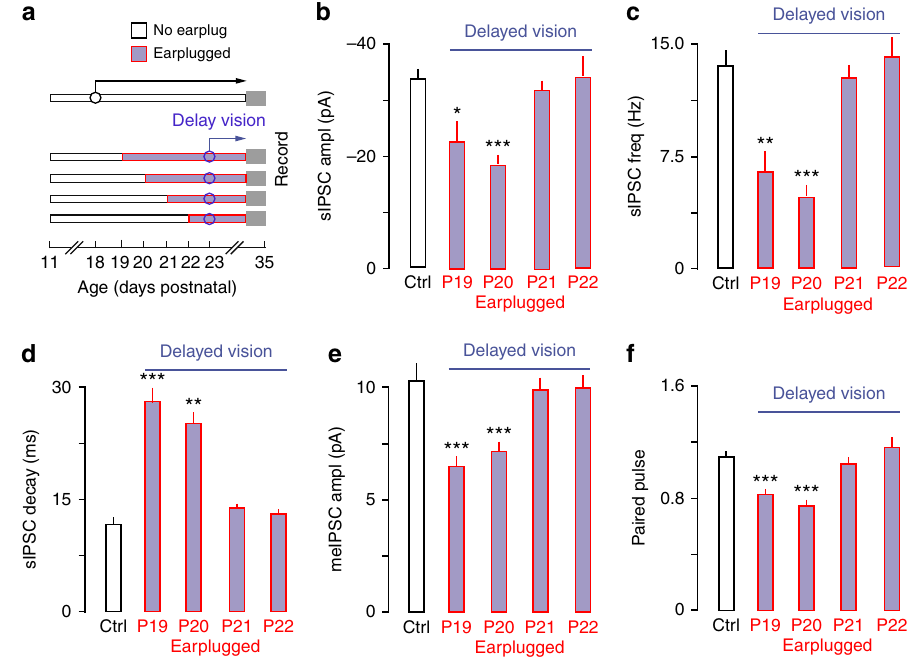
Figure 3 | Delayed eyelid opening extends the ACx CP of sensitivity to hearing loss. ( a ) Diagram shows the experimental design for data presented in b – f . Eyes were glued shut until P23 and earplugs were inserted on P19, 20, 21 or 22 and maintained until the day of recording (P29–P35). Sample size; IPSCs: Control, n ¼ 40; EP19, n ¼ 15; EP20, n ¼ 14; EP21, n ¼ 11; EP22, n ¼ 22. ( b – d ) Bar plots show that delayed eyelid opening led to decreased sIPSC amplitude and frequency, as well as slower decay time constants when ears were plugged at P19–P20, but not P21–P22. ( e , f ) Bar plots show that delayed eyelid opening led to decreased meIPSC amplitude and depressed PPRs when ears were plugged at P19–P20, but not P21–P22. Experiments were